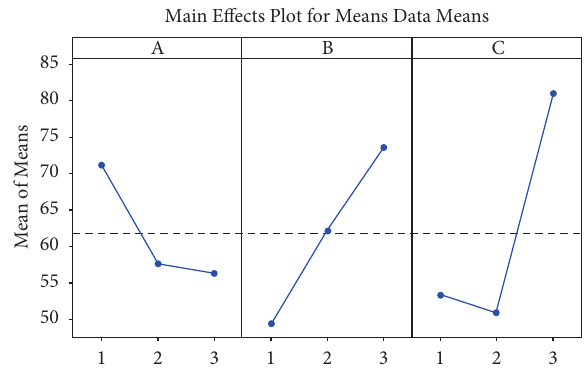
Figure 5: Main effect plot for the mean (traverse force).